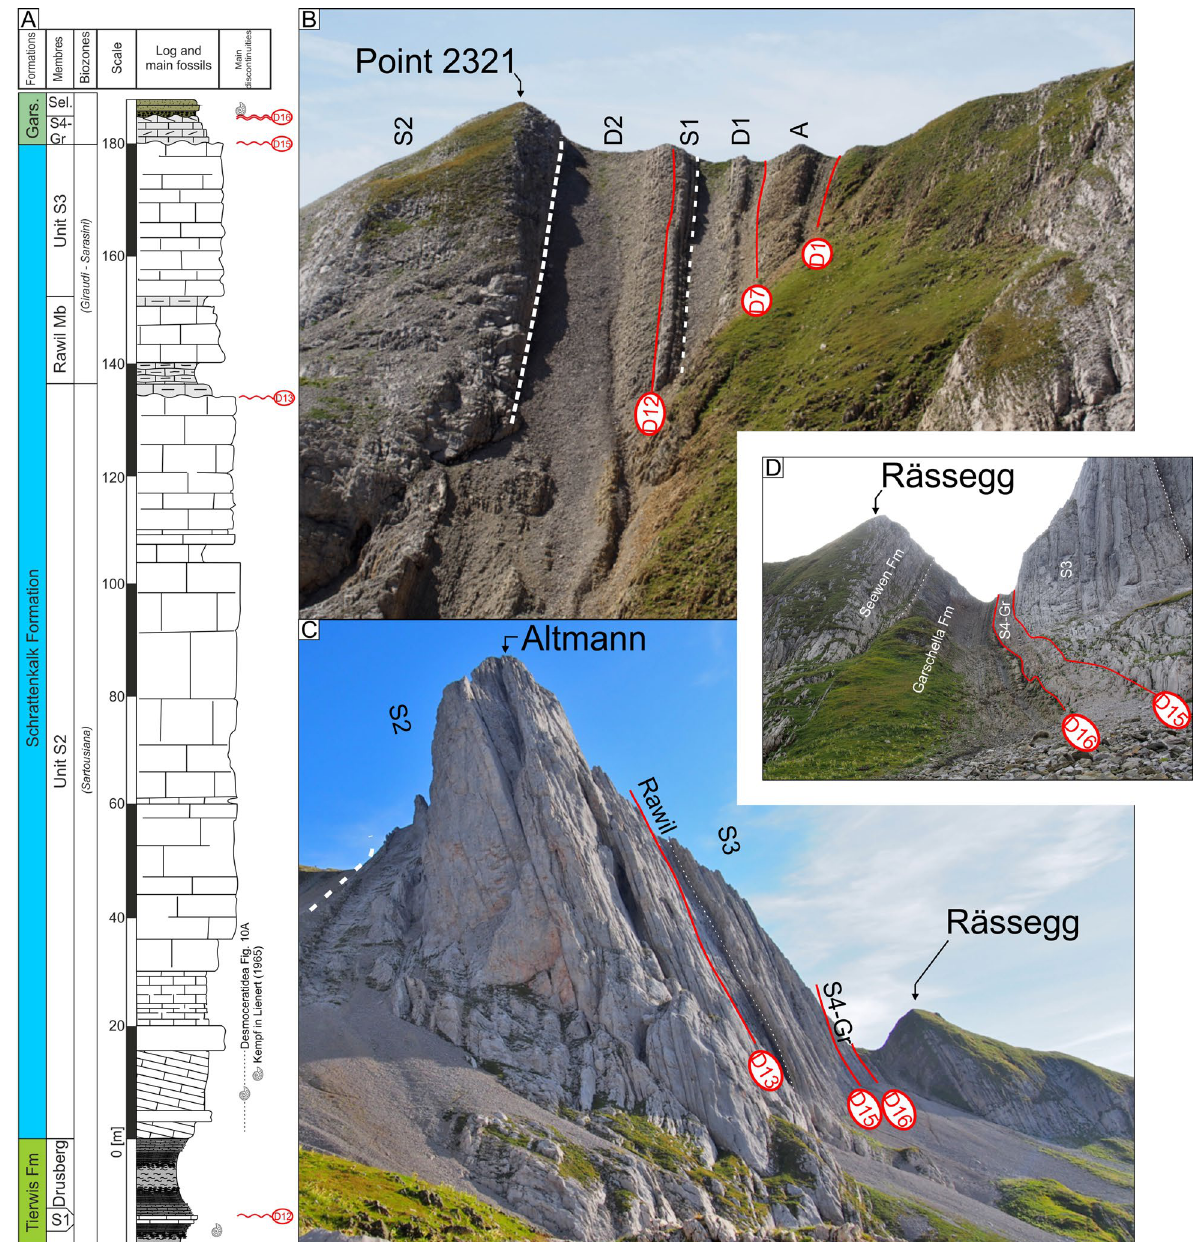
Fig. 10 A Altmann section. Lithological log modified after Wissler (2001) with discontinuity surfaces (D1 to D16). B Overview of the section in the face of our Altmann section, looking south westward. C Overview of the Altmann section looking north eastward. D Focus on the uppermost levels of unit S3, the unit S4-Gr and the overlying Garschella and the Seewen